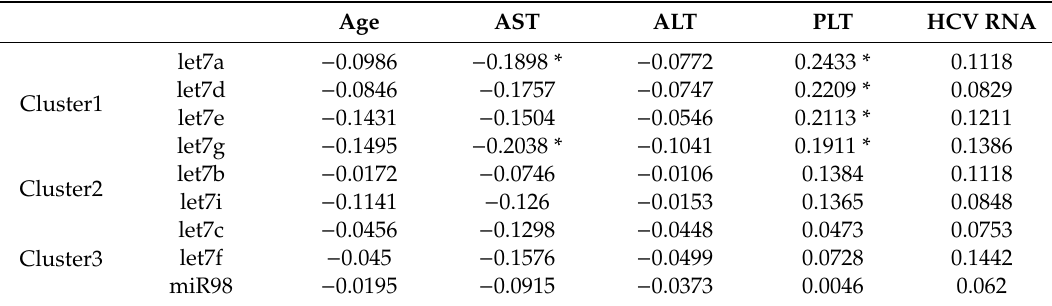
1 Data represents correlation between miRNA expression and the values of each clinical parameter, as reported in Table 1. Correlation was determined using Pearson’s test. AST, aspartate aminotransferase; ALT, alanine aminotransferase; PLT, platelet count; HCV, hepatitis C viral load. * = p < 0.05 following the Bonferroni correction ( α =